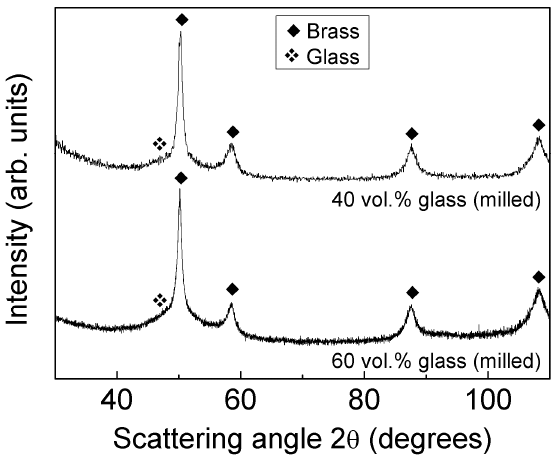
Figure 10. XRD patterns (Co- K α radiation) for the glass-brass composite powders milled for 20 h.